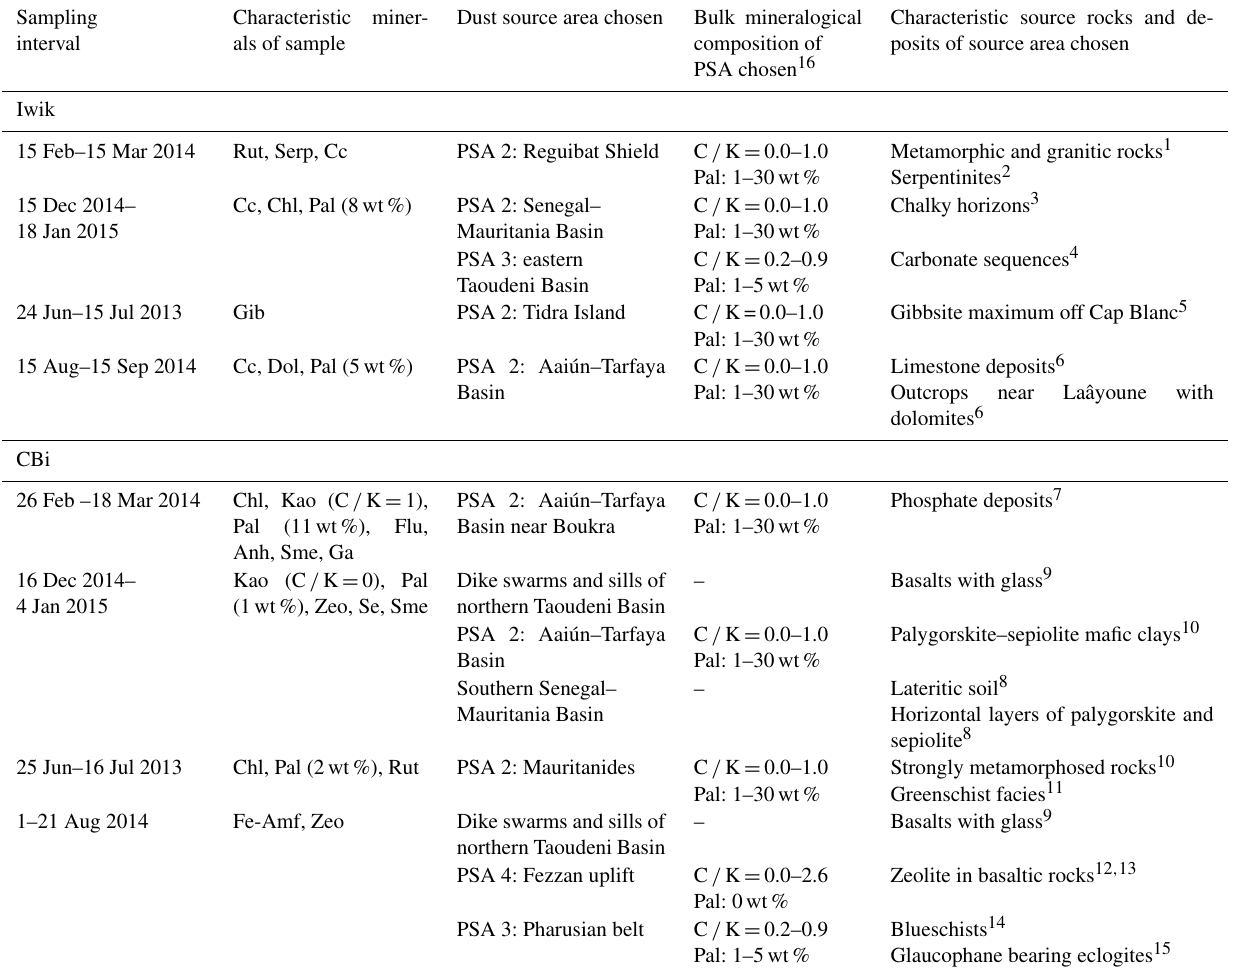
Table 7. Overview of the source areas chosen and the tracer minerals of the individual samples, together with the given characteristics of the source areas according to